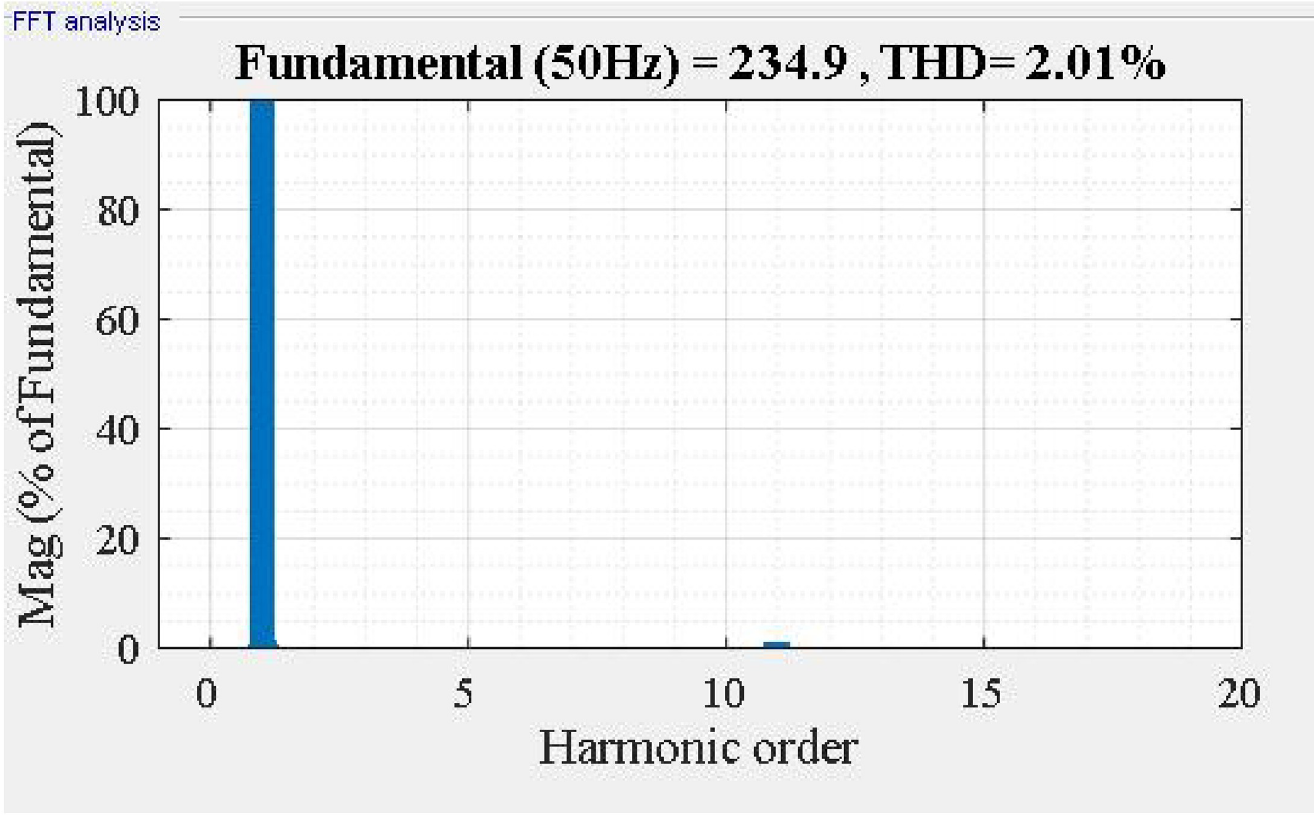
Fig 7. Frequency spectrum of supply current i sa